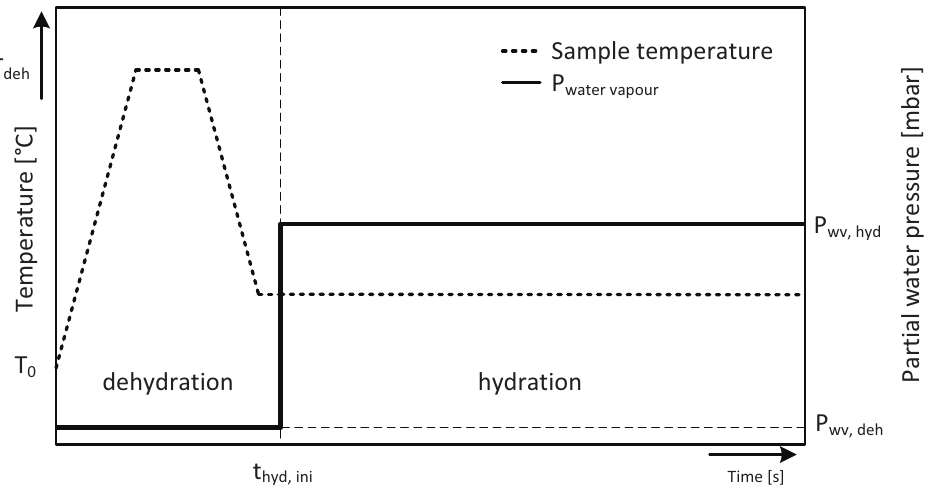
Figure 3. Representation of a typical STA run (not to scale). The partial water pressure is indicated by the solid and dashed lines. The temperature is indicated by the dotted